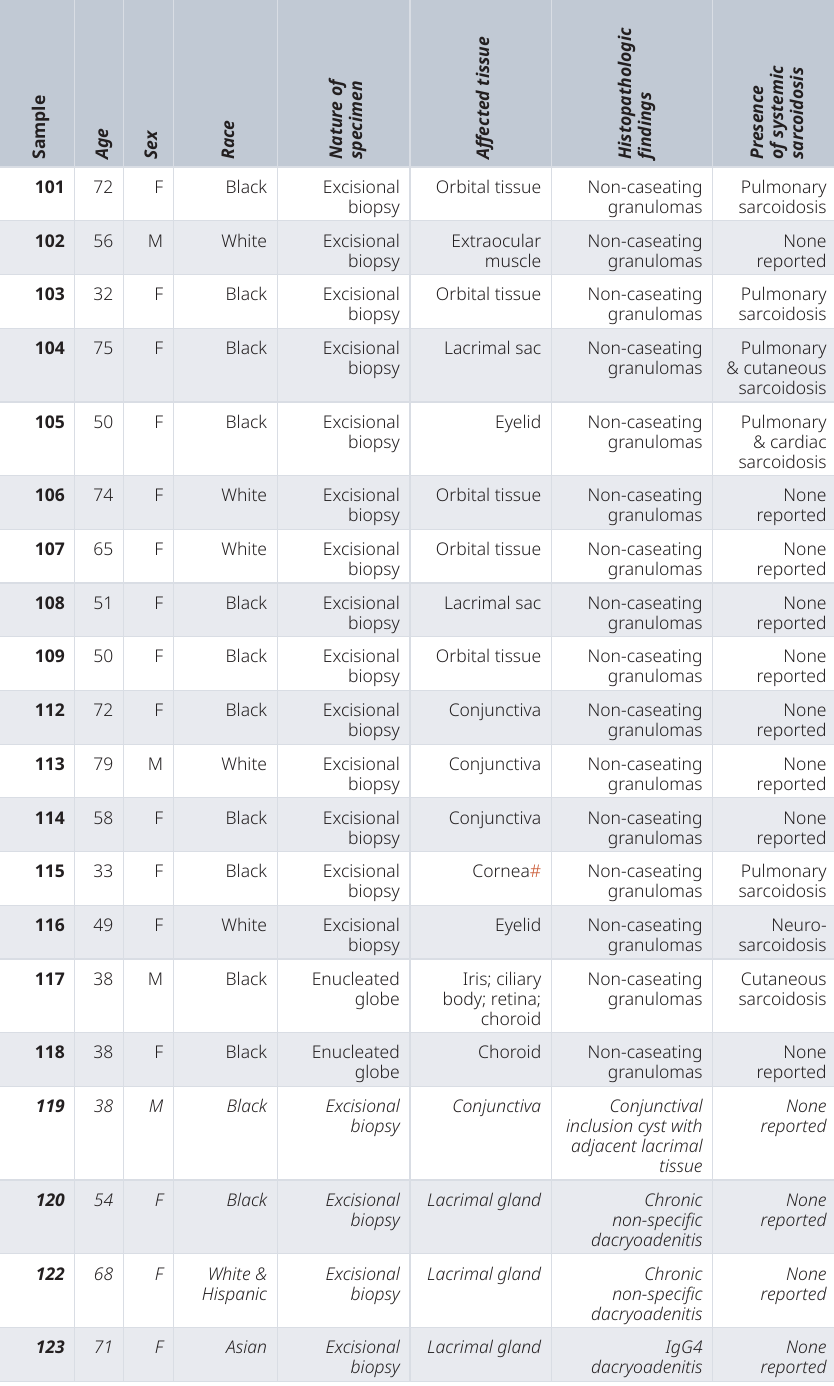
*The rows with roman text represent the cases whereas the rows with italicized text represent the controls. # This patient also had sarcoidosis-associated panuveitis of the ipsilateral